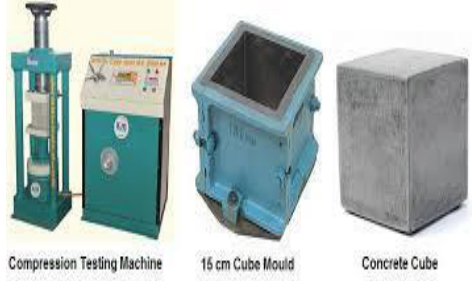
Fig. 1. Concrete cube for compressive strength